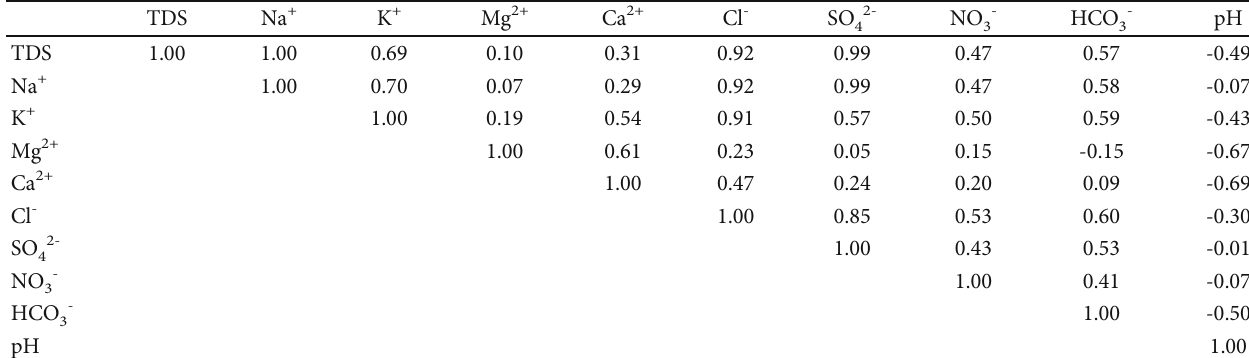
Table 5: Correlation coe ffi cient of chemical composition of groundwater.